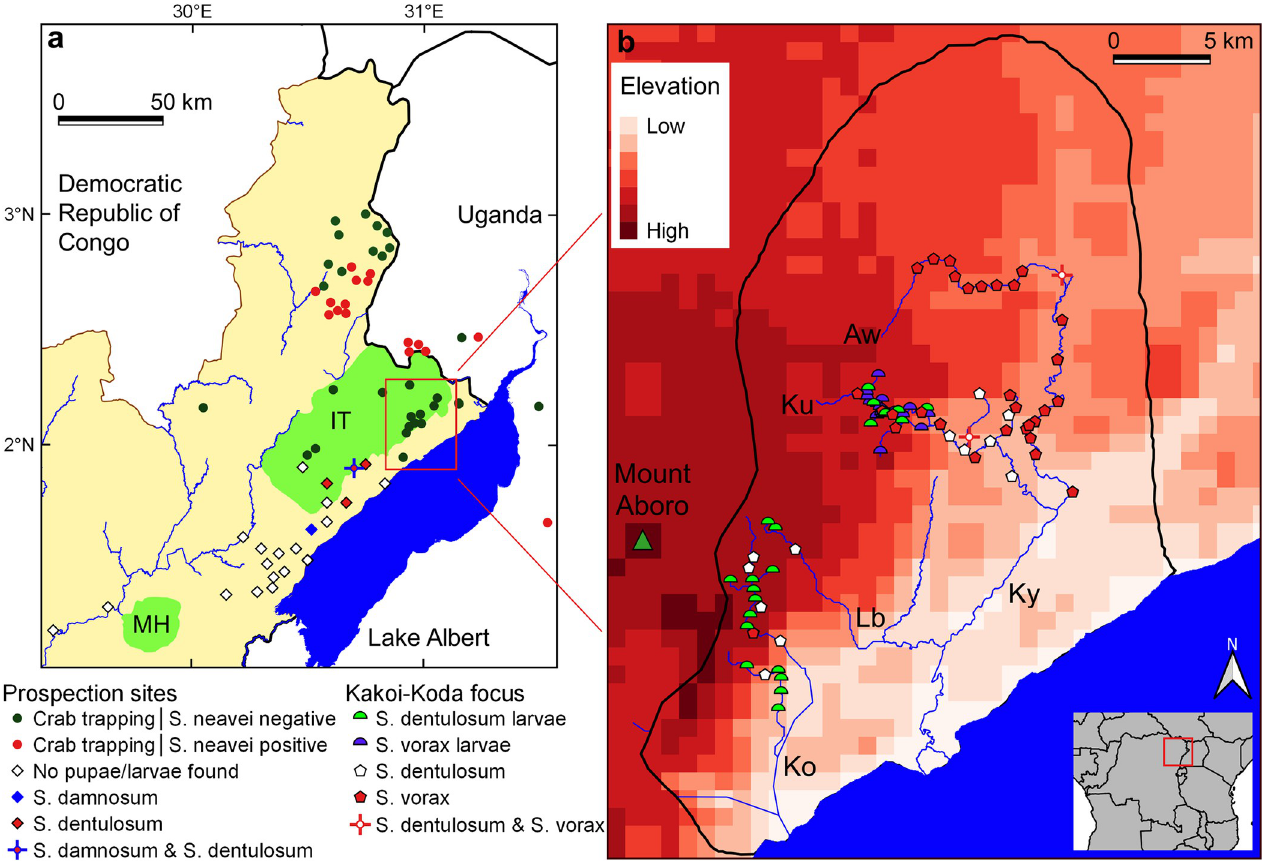
Fig 2. Overview map of historical and recent surveys for Simulium spp. A. Prospection sites in the Ituri highlands (IT), around the Mount Hoyo Reserve (MH) and some main rivers. B. Kakoi-Koda focus with sampled streams (Aw: Awoo, Ku: Kuda, Lb: Lebu, Ky: Kakoi, Ko: Koda) (produced in QGIS [50]).